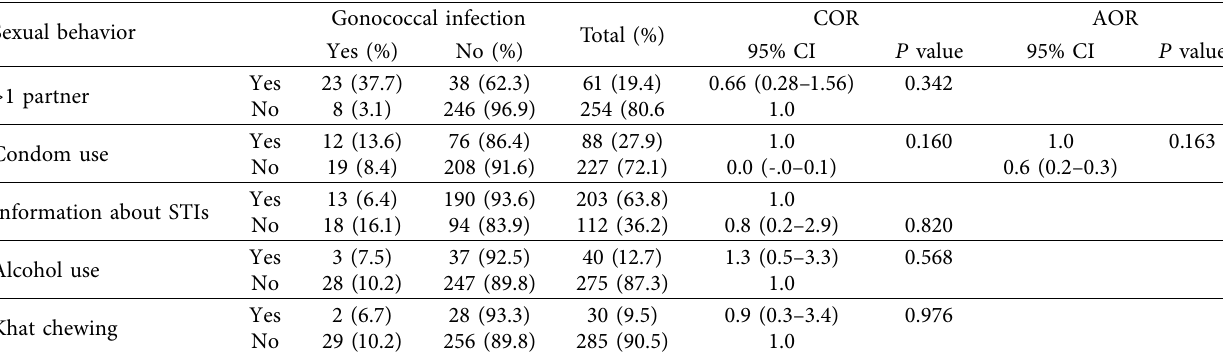
Table 2: Sexual behavior and awareness of patients towards gonococcal infections at Jimma Town Private Clinics, Jimma, Ethiopia. Sexual